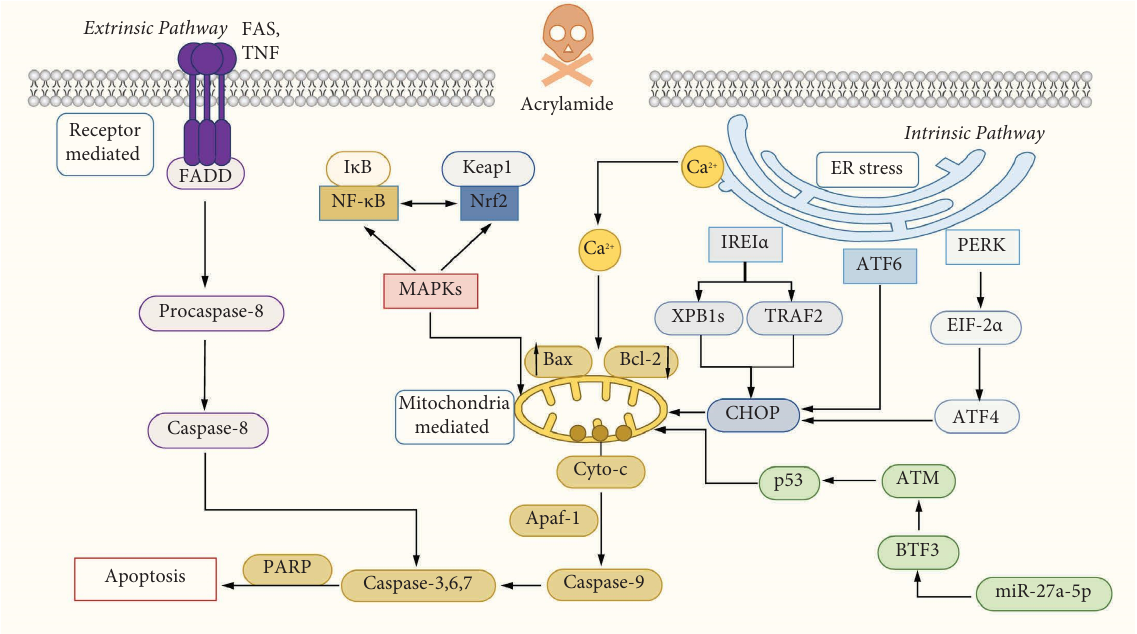
Figure 3: Molecular mechanism of apoptosis pathway induced by